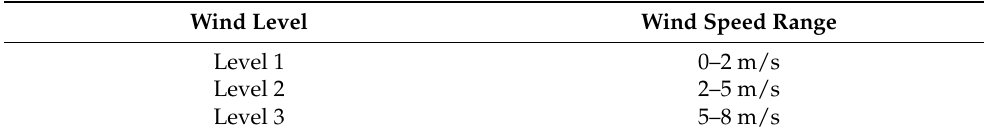
Table 2. Wind levels recorded during the flight experiments.